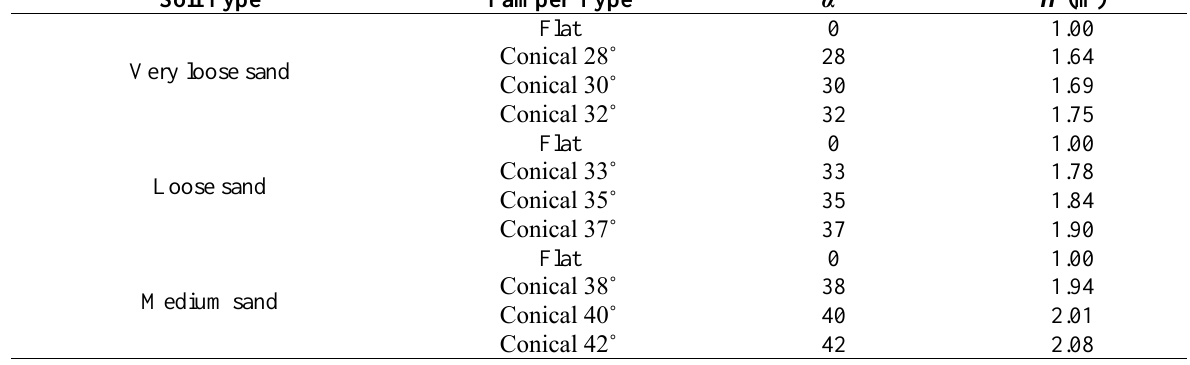
Table 3. Specifications of tampers used in the numerical analysis